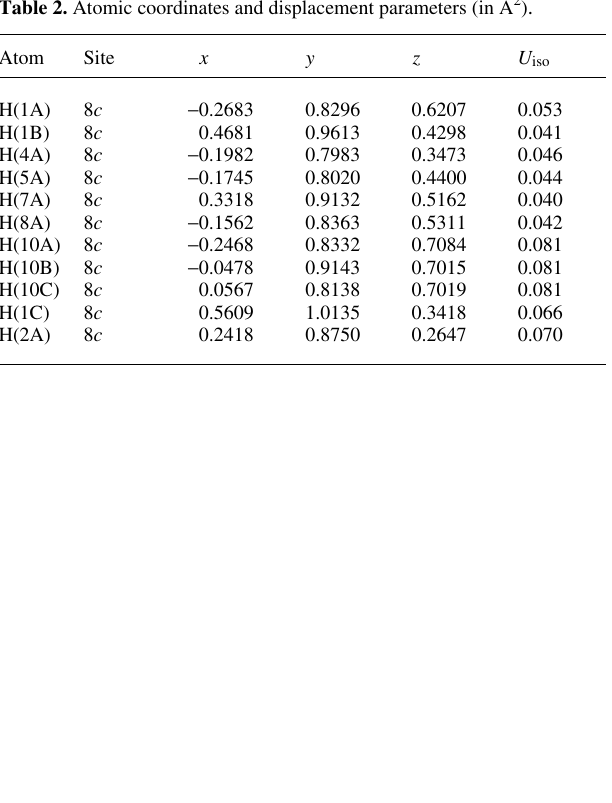
Table 2. Atomic coordinates and displacement parameters (in Å 2 )